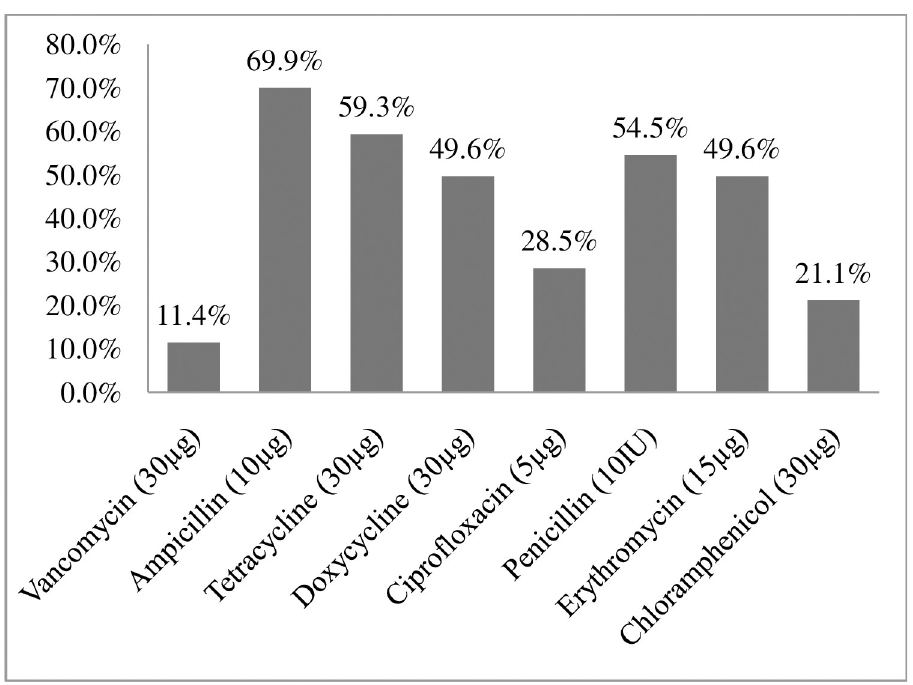
Fig 1. Antimicrobial resistance patterns of isolated Enterococcus spp among clients attending ART clinic at Arba Minch General Hospital, Southern Ethiopia October 2020 (n = 123).